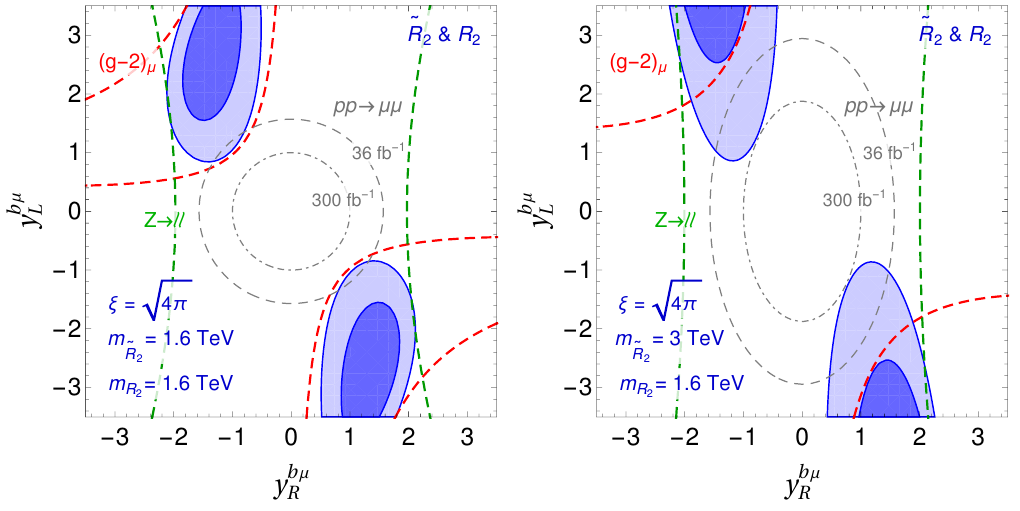
Figure 6 . The values of y b(cid:22) vs. y b(cid:22) for the e R 2 & R 2 scenario that satisfy relevant flavor constraints R L and address ( g 2) (cid:22) are shown in dark (light) blue to 1 (cid:27) ( 2 (cid:27) ) accuracy. The individual 2 (cid:27) (cid:0) constraints from the Z -pole observables and ( g 2) (cid:22) are represented with green and red dashed (cid:0) lines, respectively. The (projected) LHC limits from the study of pp (cid:22)(cid:22) at high- p T , at the 2 (cid:27) ! level, for ( 300 fb (cid:0) 1 ) 36 fb (cid:0) 1 worth of data are shown with (dash-dotted) dashed gray lines